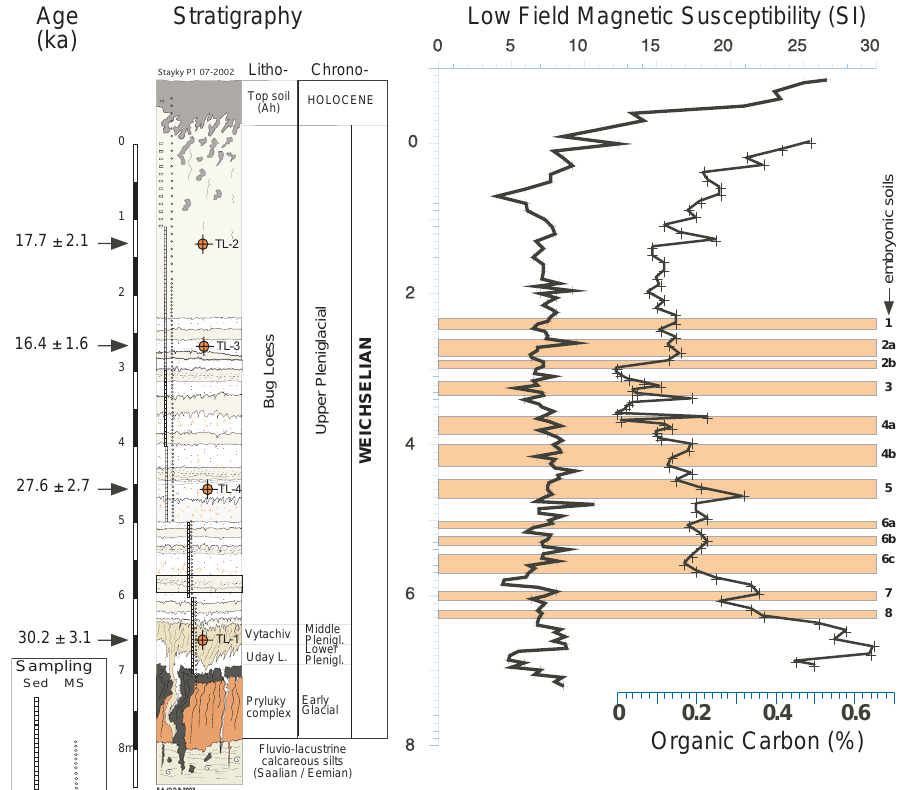
Fig. 3. Stayky loess sequence: stratigraphy and IRSL dates, low field magnetic susceptibility measured on the section, and organic carbon records, with the count of the embryonic soils